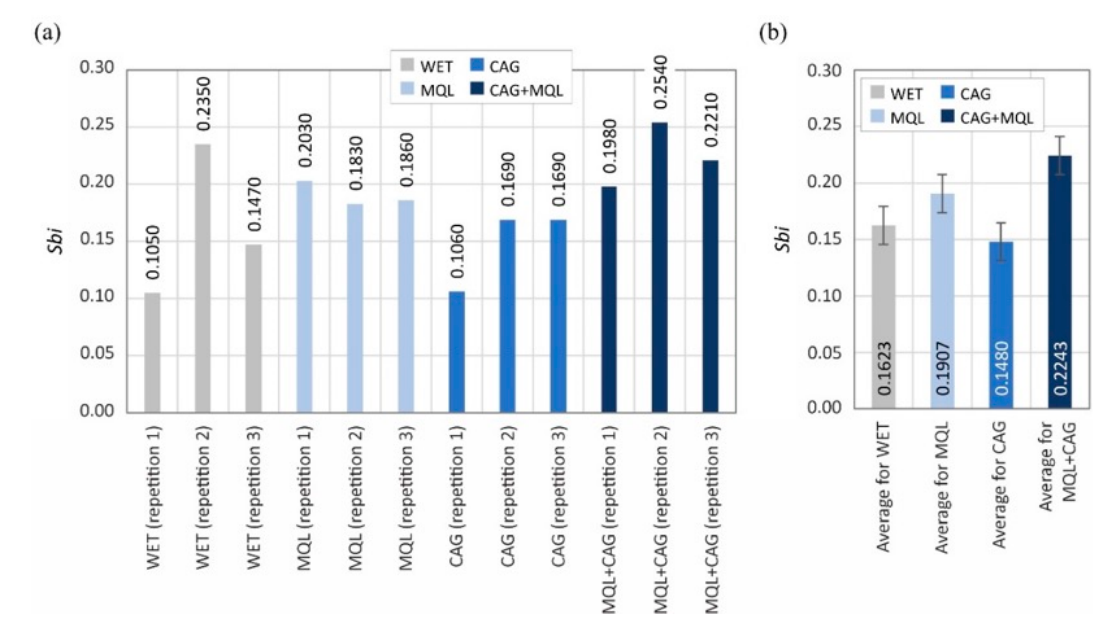
Figure 13. Chart of changes in the developed interfacial area ratio Sdr : ( a ) results for the twelve blades selected for the surface texture measurements; ( b ) mean values of the parameters divided by cooling and lubrication methods of the grinding zone used during the shaping of the blades (error bars represent the standard error equal to the standard deviation σ divided by the square root of the total number of samples).